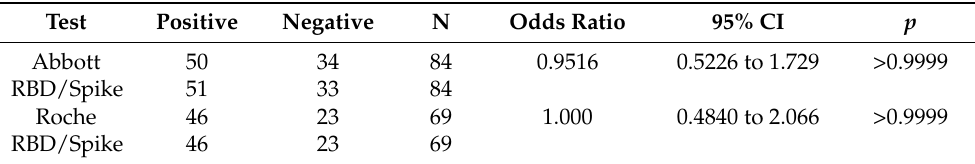
Table 1. Comparison between the SARS-CoV-2 ELISA and the commercial assays using a two-tailed Fisher’s exact